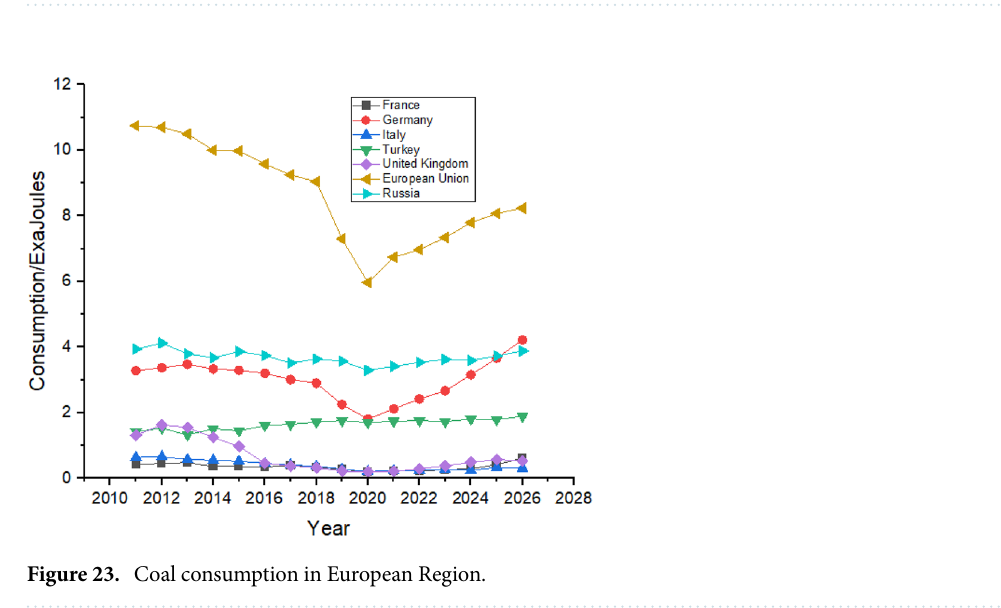
Figure 22. Coal consumption in Australia and South Africa.